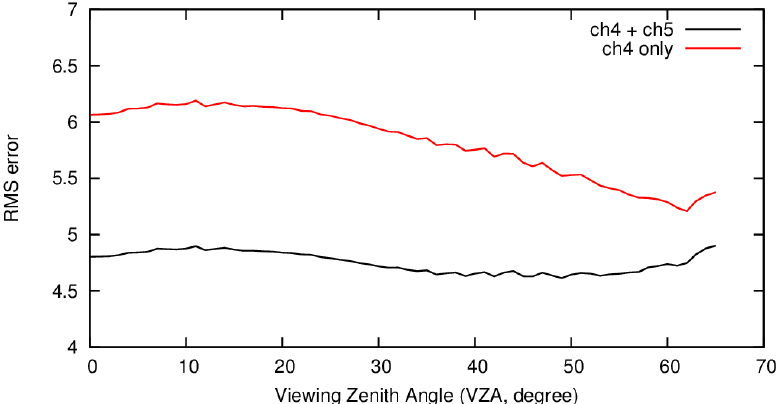
Figure 4. Variation of the RMS error as a function of the Viewing Zenith Angle (VZA) for the two-channel regression with Equation (1) (black) and the regression without Channel 5 (red curve).